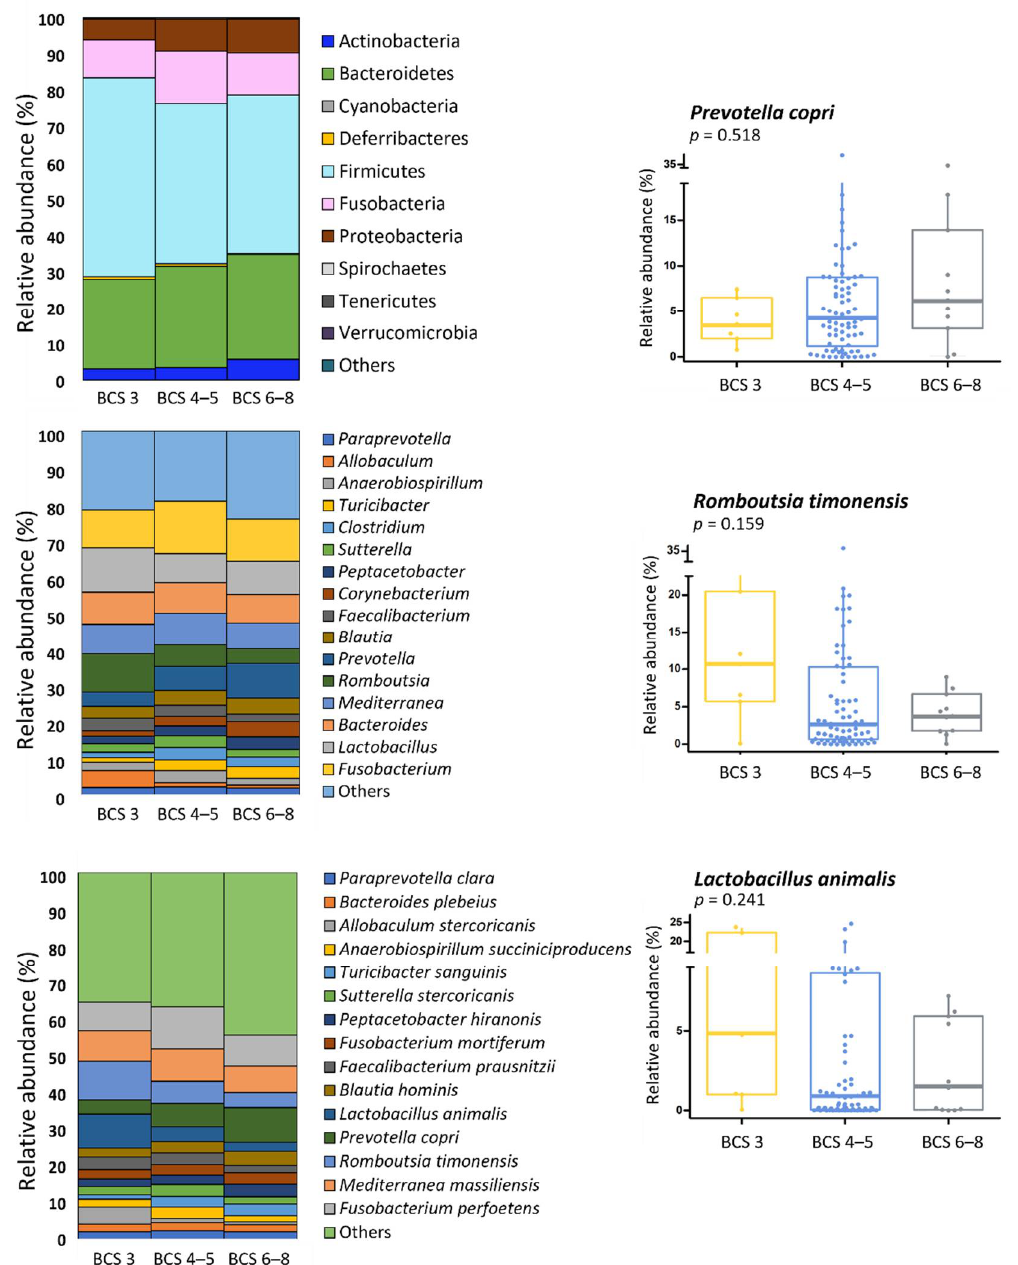
Figure 7. Gut microbial composition and box plots in different body condition score (BCS) groups. Major bacterial groups at the phylum ( ≥ 0.01%), genus ( ≥ 2%), and species ( ≥ 2%) level. Box plot represents no significant difference ( p > 0.05) but shows bacterial groups that tend to increase or decrease with BCS. * Indicates that significantly different bacteria group.